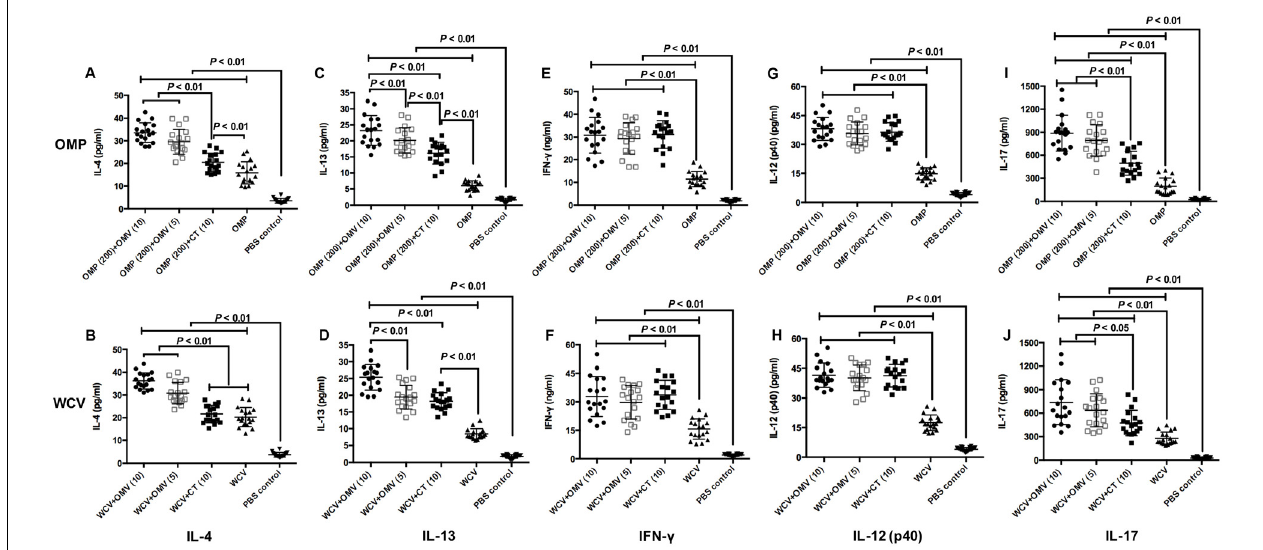
FIGURE 6 | Cytokine productions were detected by excised splenocytes from sacrificed mice at 8 weeks after first immunization. The concentrations of IL-4 (A,B) , IL-13 (C,D) , IFN- γ (E,F) , IL-12 (p40) (G,H) and IL-17 (I,J) generated by groups used OMP as vaccine (A,C,E,G,I) and groups immunized with WCV (B,D,F,H,J) were then subjected to cytokine-specific ELISAs. The results of cytokine production analysis are expressed as means ± SD ( n = 18). Means were compared using the least-significant-difference test. P < 0.05 and P < 0.01 reflect statistical significance between the related